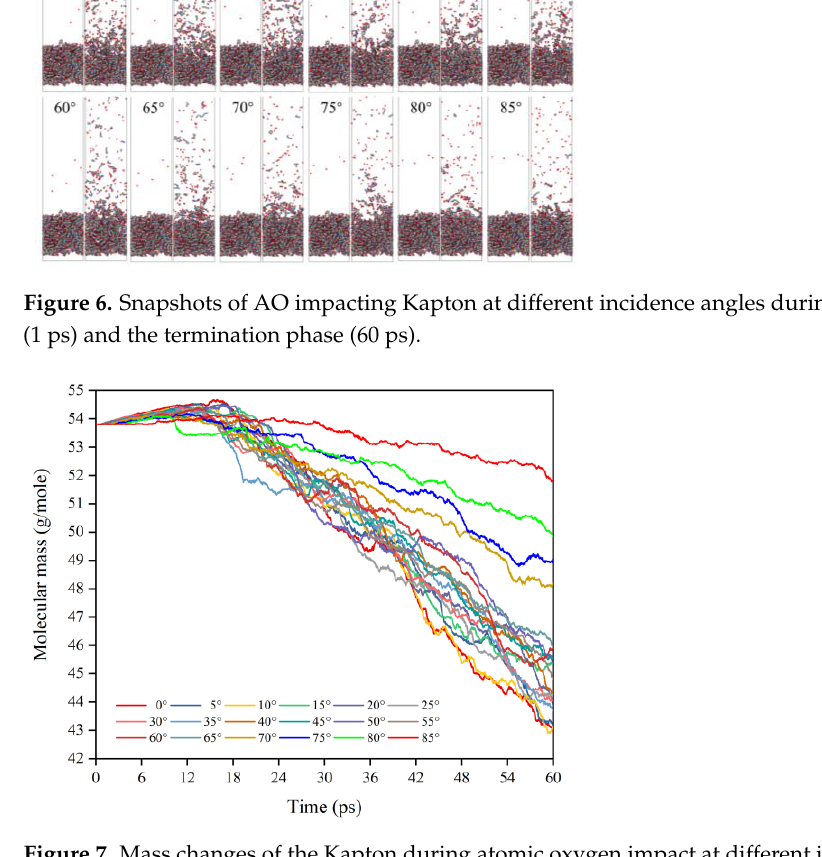
Figure 7. Mass changes of the Kapton during atomic oxygen impact at different incidence angles.